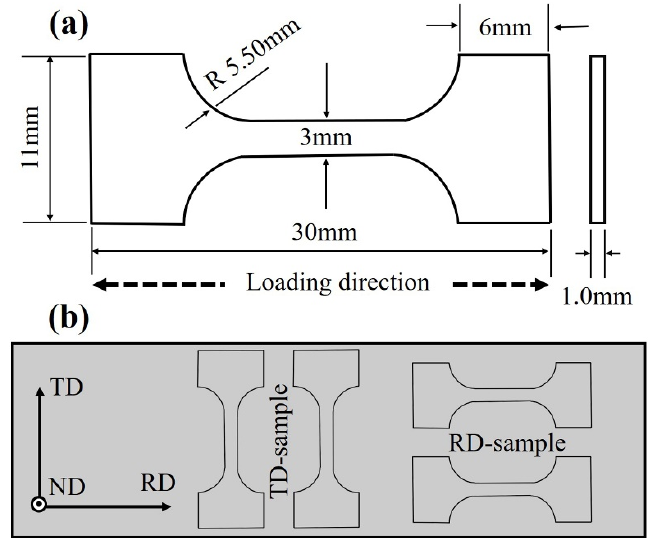
Figure 1. ( a ) Geometric dimensions of the specimen; and ( b ) the schematic diagram for the specific orientation specimen. Table 1. Slip modes available in α -Zr and the corresponding Taylor axis.